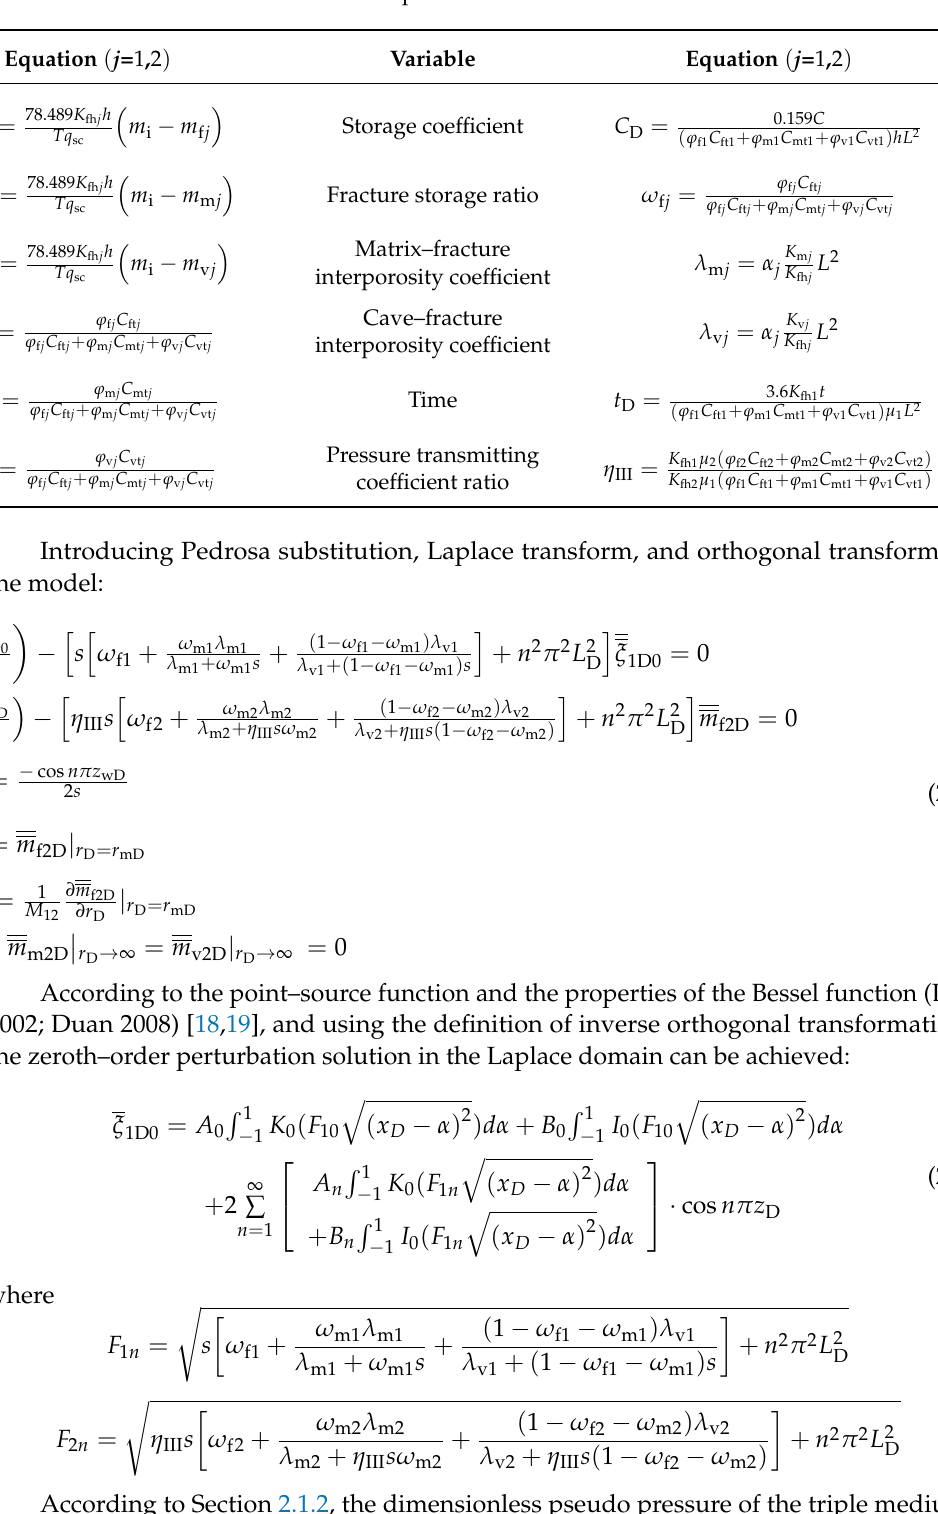
Table 2. Dimensionless variables of the triple